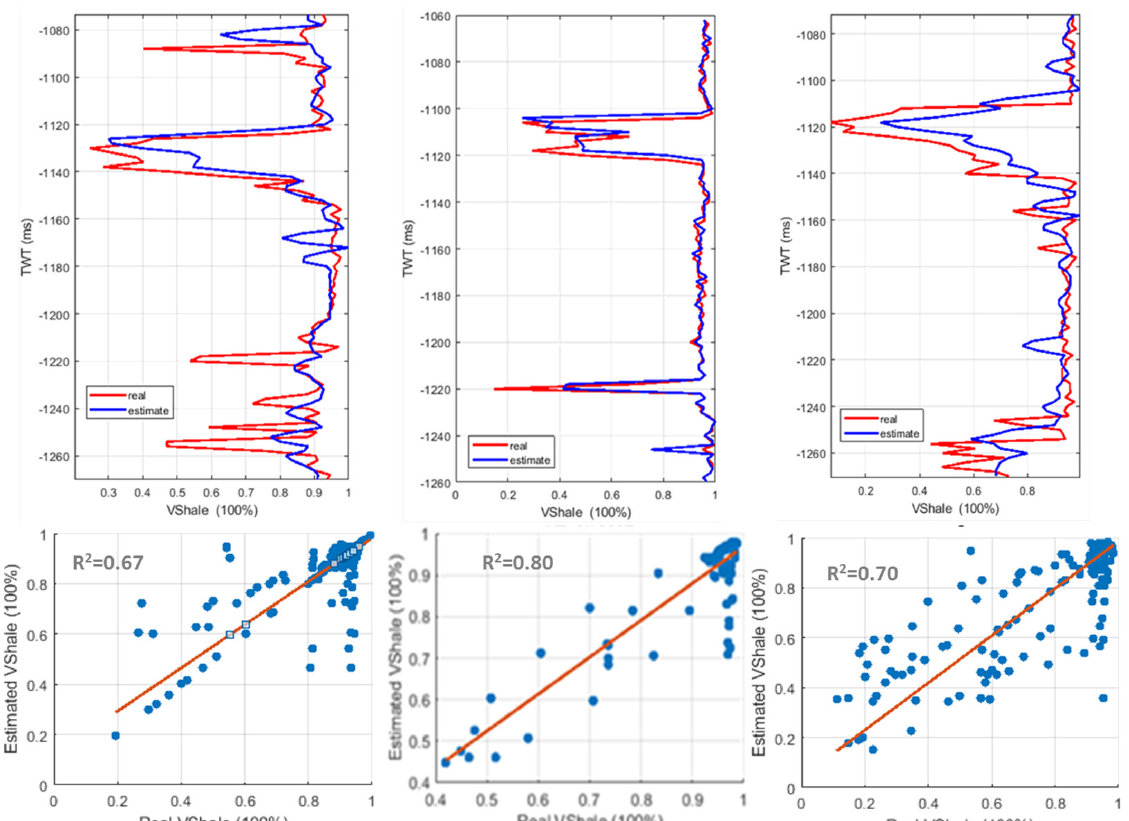
Figure 15. Overlay (upper row) and cross plots (lower row) of the estimated and real volume of shale at well locations. From left to right: (first column) Well 3 (blind), (second column) Well 1 (control), (third column) Well 2 (blind). Both estimated and real data are smoothed. Red lines in the cross plot are the best line between the real and estimated volume of shale.